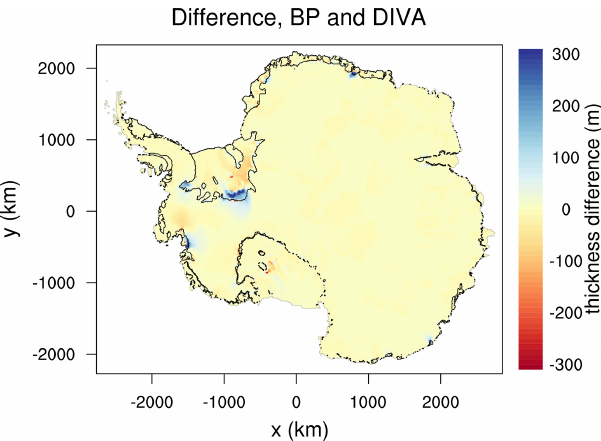
Figure 16. Difference in the ice thickness change (m) from two 550-year projection experiments on an 8km grid, comparing the Blatter–Pattyn (BP) and DIVA velocity solvers. Both runs use the nonlocal-PIGL melt scheme with ocean forcing from UKESM. The ice thins in both runs. Negative values indicate more thinning in the BP run than the DIVA run. Black lines show boundaries of floating ice at the end of the DIVA